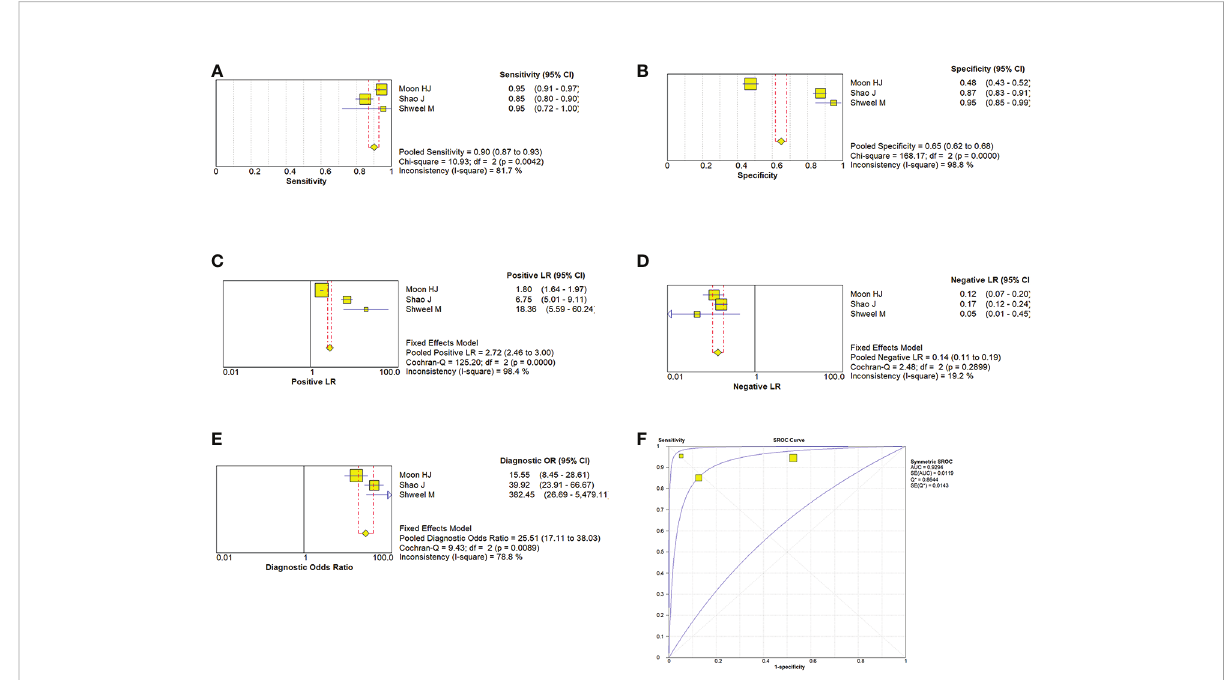
FIGURE 7 Estimates of the conventional ultrasonography combined with elastosonography for assessment for the diagnosis of thyroid nodules. (A – E) Forest plots illustrate pooled estimates (diamonds) for sensitivity (A) , speci fi city (B) , positive likelihood ratio (LR) (C) , negative LR (D) , and diagnostic odds ratio (E) and corresponding 95% CIs for pooled estimates. (F) Summary receiver operating characteristic (SROC) plot for assessing accuracy with corresponding curves indicative of upper and lower bounds of 95% CI. AUC = area under curve, SE = standard error, Q* = summary measure of accuracy derived from the SROC